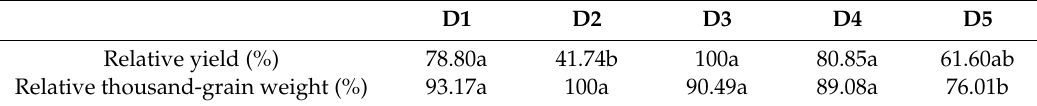
Table 2. E ff ects of lateral line depth on spring wheat yield and